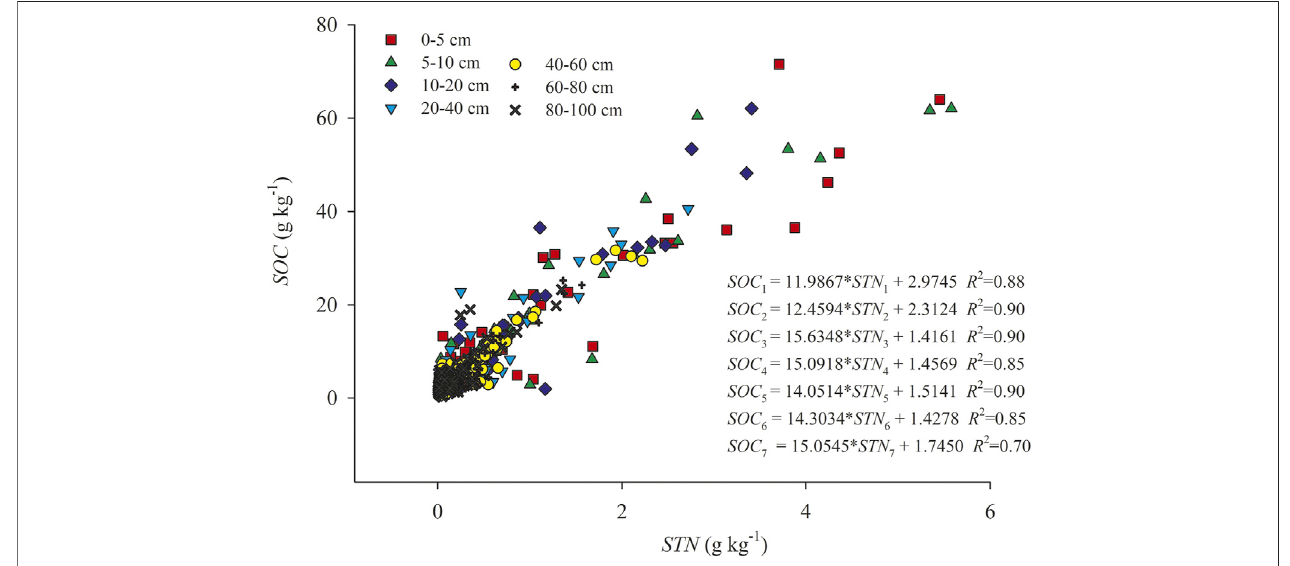
FIGURE 3 | Scatterplots for the relationships between the soil organic carbon ( SOC ) and soil total nitrogen ( STN ) concentrations in the different soil layers. SOC values 1 to 7 correspond to depths from 0 to 5 cm to 80 – 100 cm, respectively. All regressions were statistically signi fi cant ( p < 0.05).